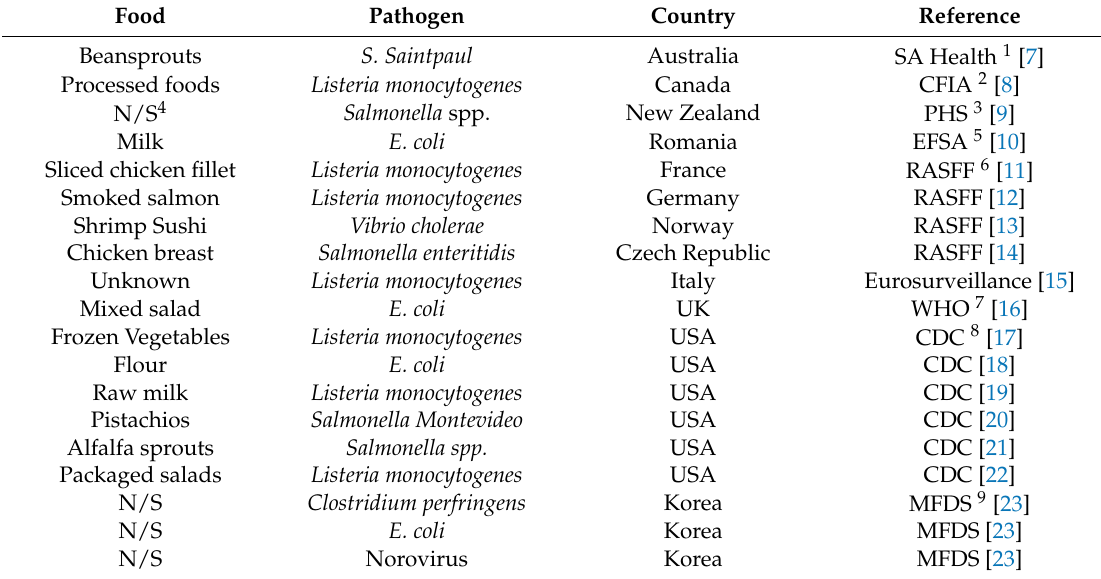
Table 1. Selected 2016 global foodborne outbreaks by food